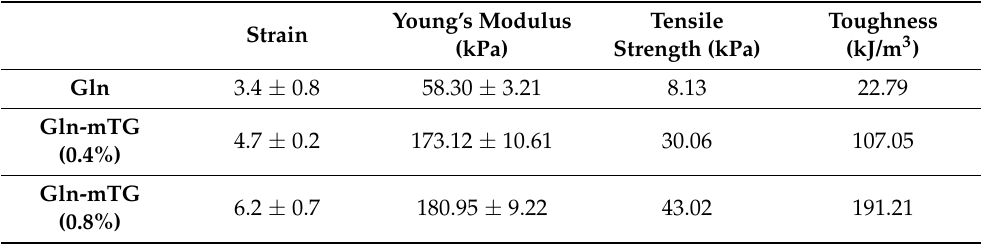
Figure 2. The structural and mechanical properties of NP-doped GelMA. ( a ) The appearance and color of NP-doped GelMA thin films. ( b ) SEM images of the morphology of each NP. ( c ) SEM images showing the porous structure of NP-doped GelMA hydrogels. ( d ) Stress–strain curves of GelMA and NP-doped GelMA. ( e ) The calculated Young’s modulus of each sample. Table 1. Mechanicial Properties obtained from stress-strain curves of Gln and Gln-mTG